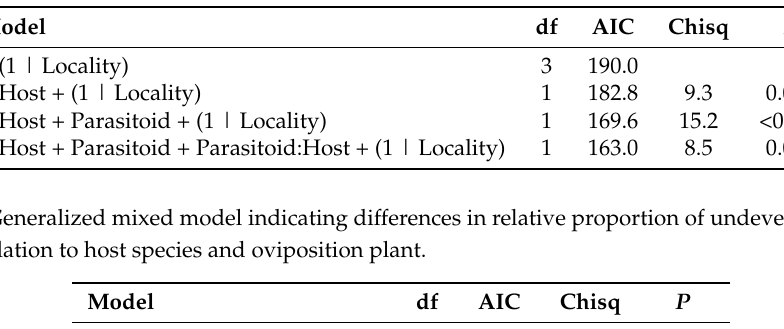
Figure 3. Proportion of undeveloped eggs per damselfly species. Table 5. Effect of parasitoid species and damselfly species (host) on parasitoid abundance.